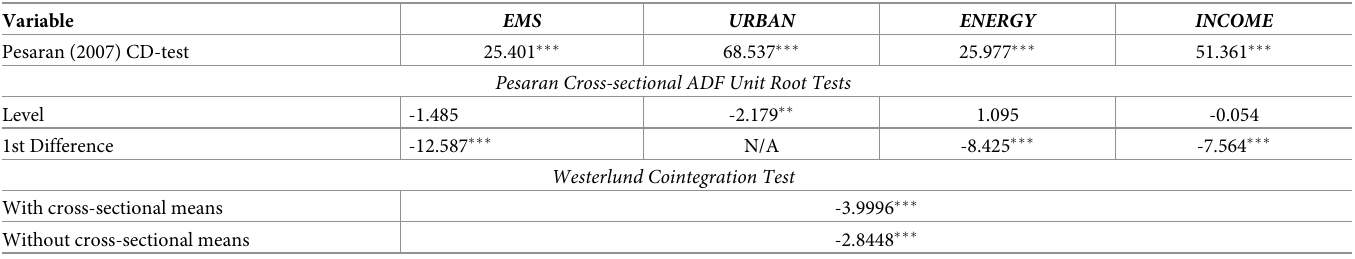
Table 3. CSD, panel unit root, and cointegration